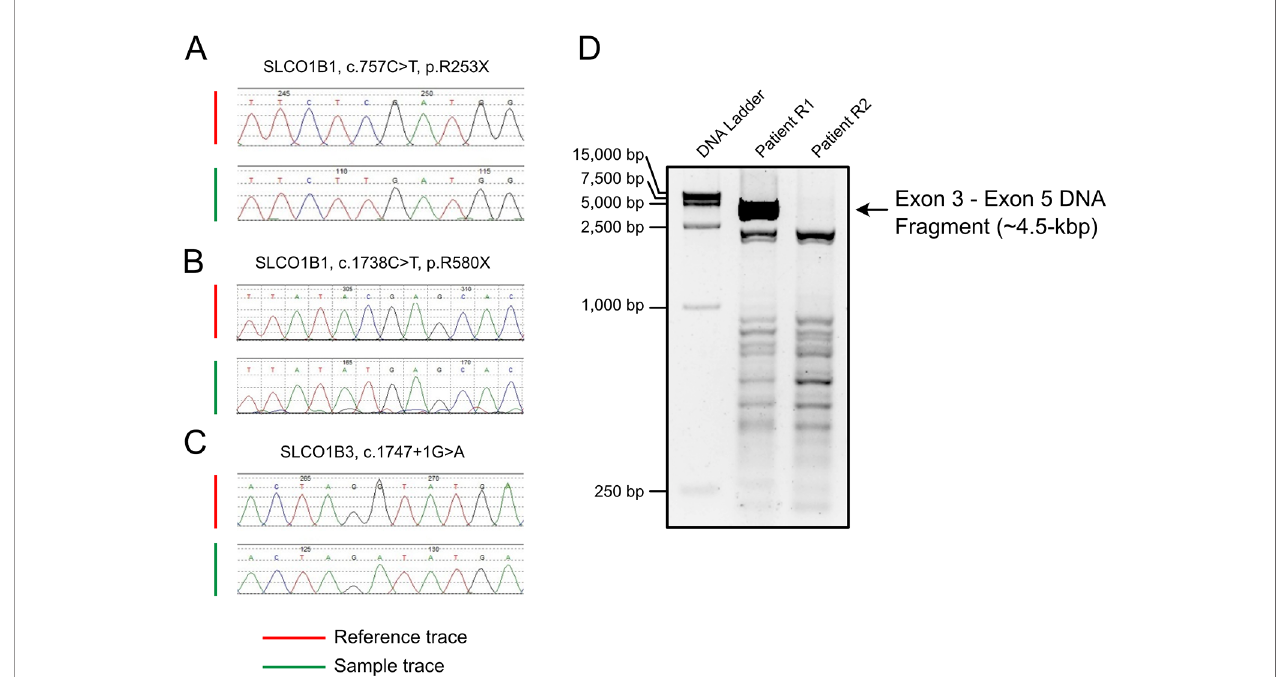
FIGURE 1 | PCR ampli fi cation and Sanger sequencing of the target region in both patients with Rotor syndrome. (A – C) The sequences of three pathogenic point mutations. (D) Long-range PCR using the exon 3 forward primer and exon 5 reverse primer failed to produce the predicted ~4.5-kbp exon 3 to exon 5 ampli fi cation product.